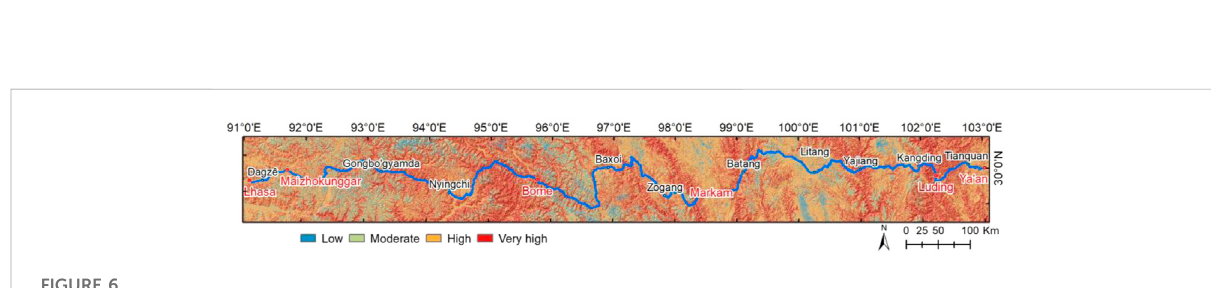
FIGURE 6 Landslide susceptibility map generated by SOM.